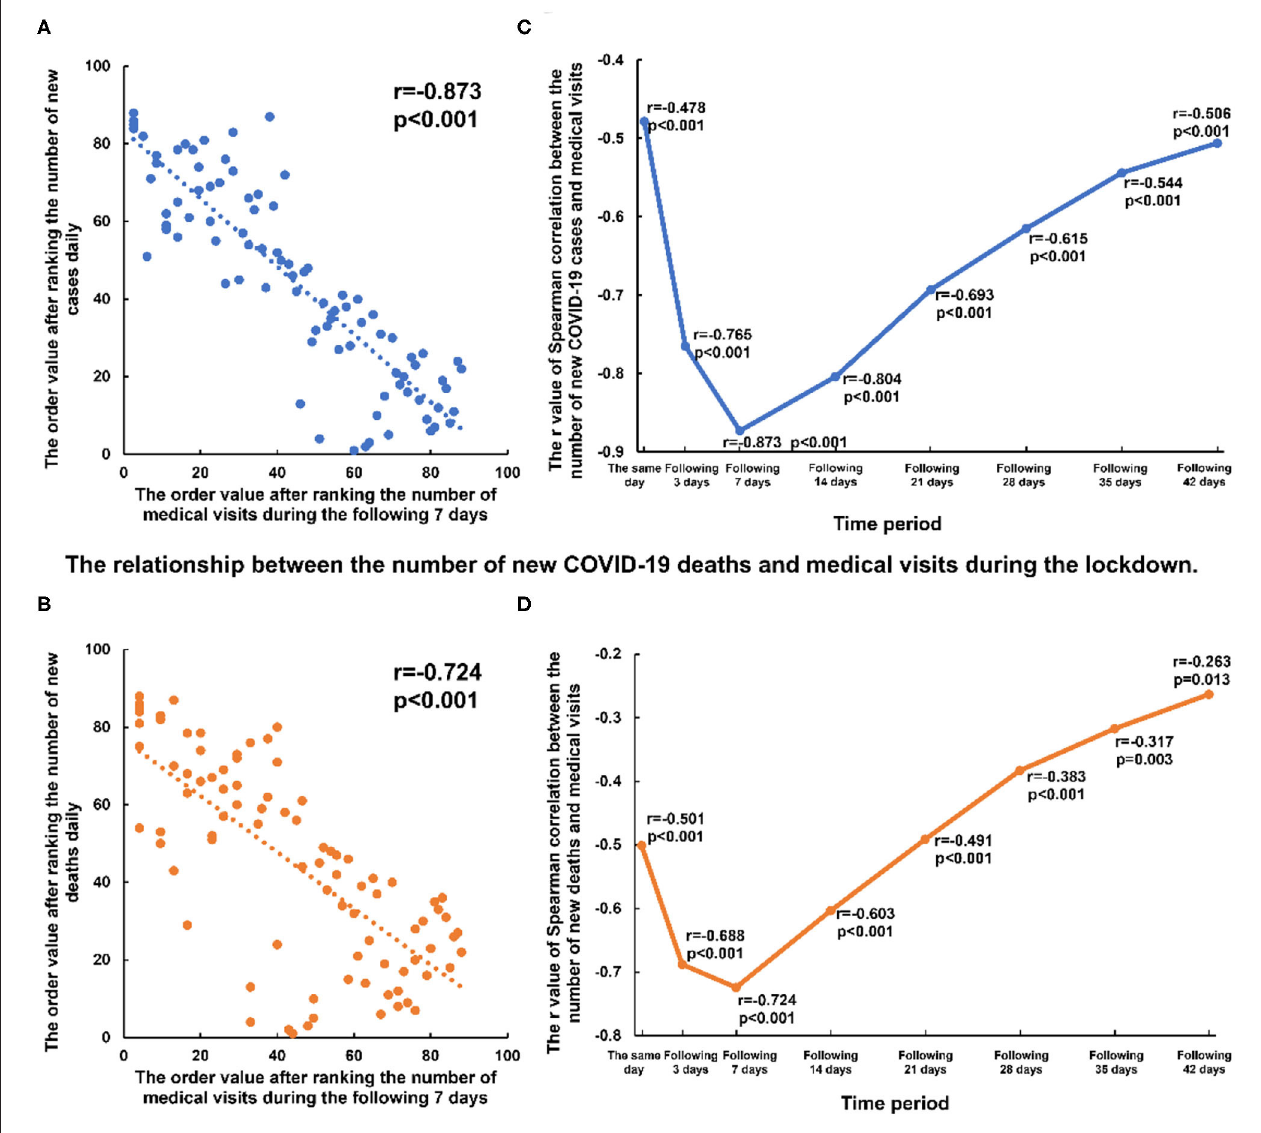
FIGURE 3 | Correlation between the number of new COVID-19 cases or deaths and medical visits of the following days during the lockdown. (A,B) the negative correlation between the new COVID-19 cases or deaths and the number of medical visits with ECG examination of the following 7 days during the lockdown. (C,D) the correlation coefficient (r) between the new COVID-19 cases or deaths and the number of medical visits of the same day and the following 3–42 days.